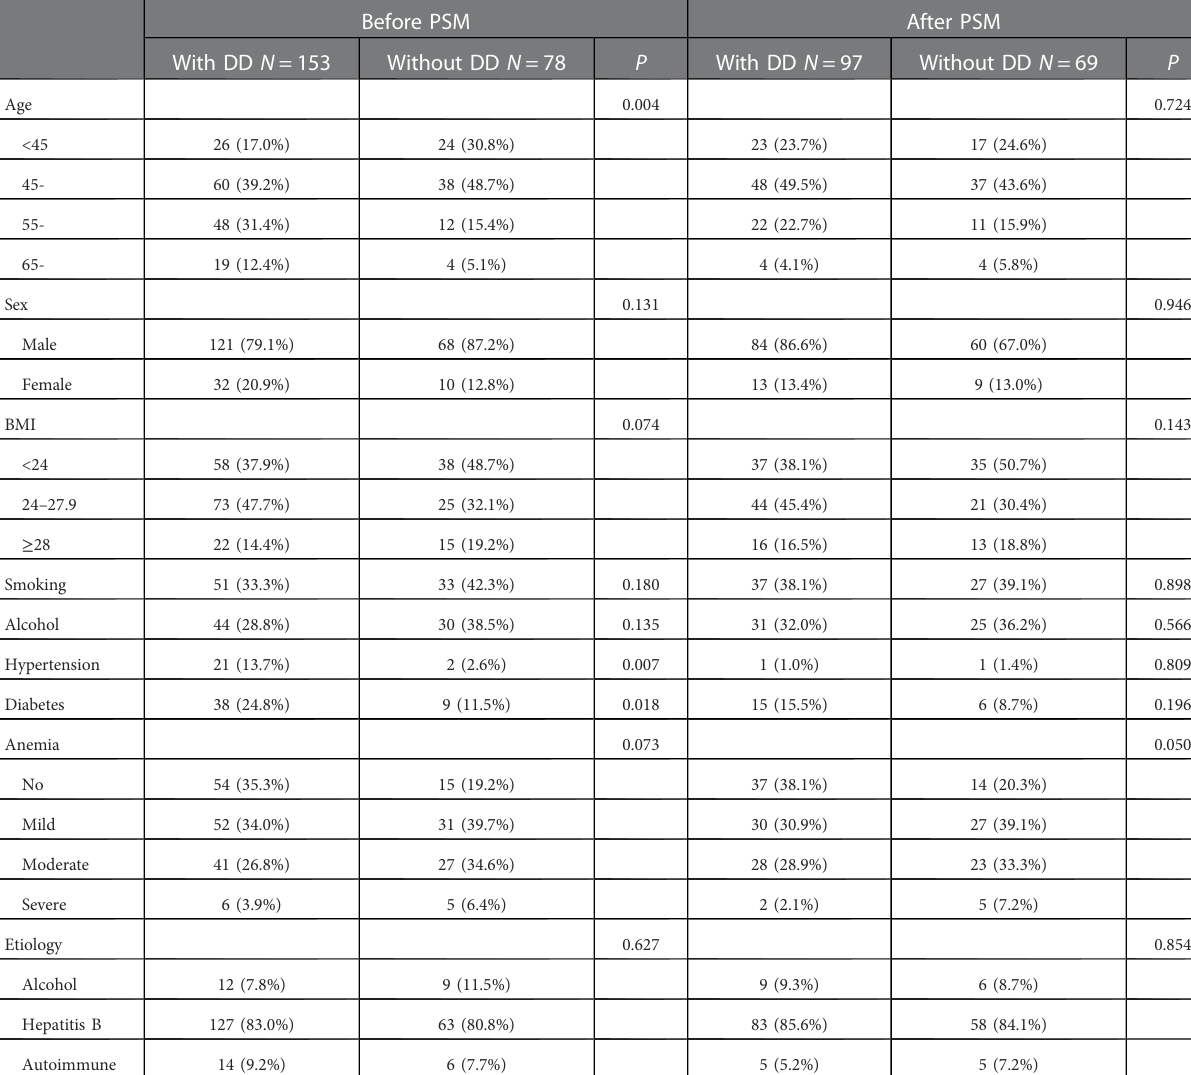
TABLE 1 Comparisons of baseline characteristics between patients with and without DD. Before